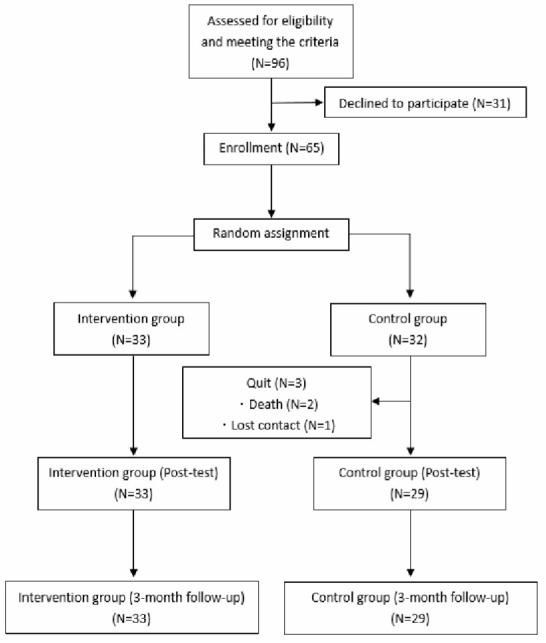
Research procedure.